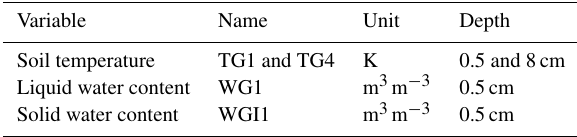
Table 6. List of soil parameters simulated by SURFEX.